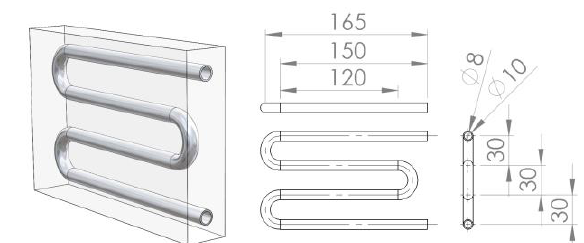
Fig. 3. The analysed heat exchanger 2.2 Pre-processing